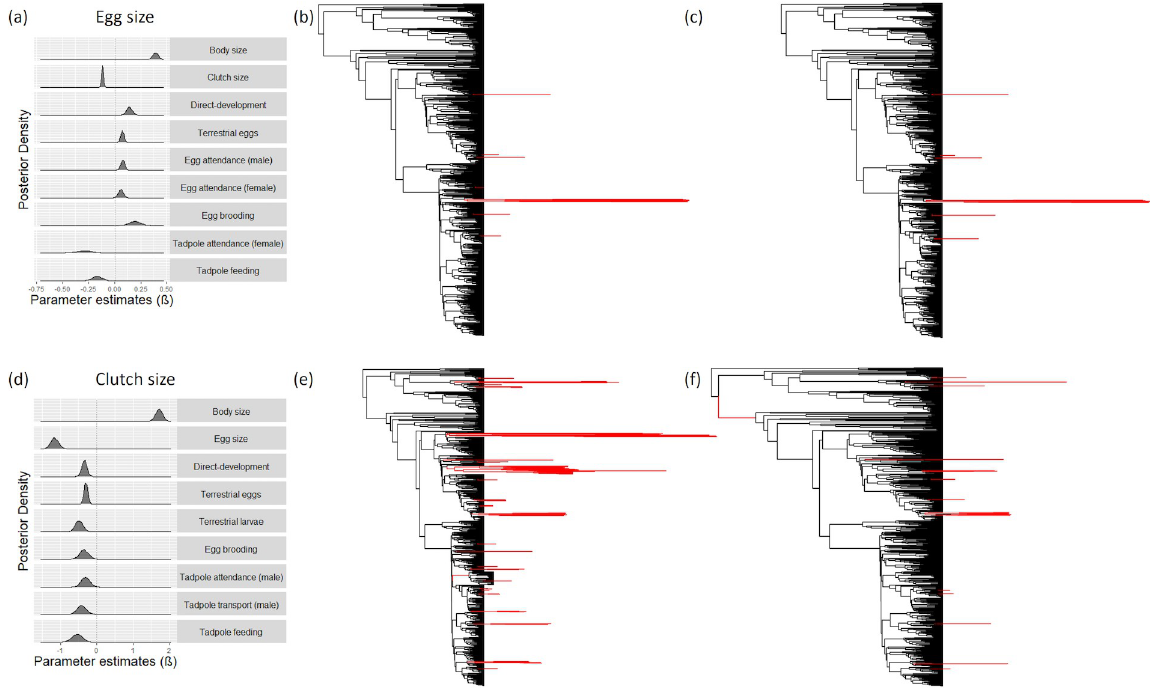
Fig 2. Egg and clutch size evolution. In (A) and (D), posterior distributions of the parameter estimates ( β ) of the significant predictors in the reduced model (S3B and S3D Table) for egg size (A) and clutch size (D), using phylogenetic variable rates models. Branches of the amphibian phylogeny that exhibit exceptional rates of evolution ( r > 1 in � 95% of the posterior distribution) are depicted in red for egg size (simple model, with only body size and clutch size as predictors, in (B), and reduced model in (C)) and for clutch size (simple model, with only body size and egg size as predictors, in (E), reduced model in (F)). The identity of these branches is reported in S5 Table for egg size and S6 Table for clutch size. Raw data for these analyses are available in S1 and S2 Data.